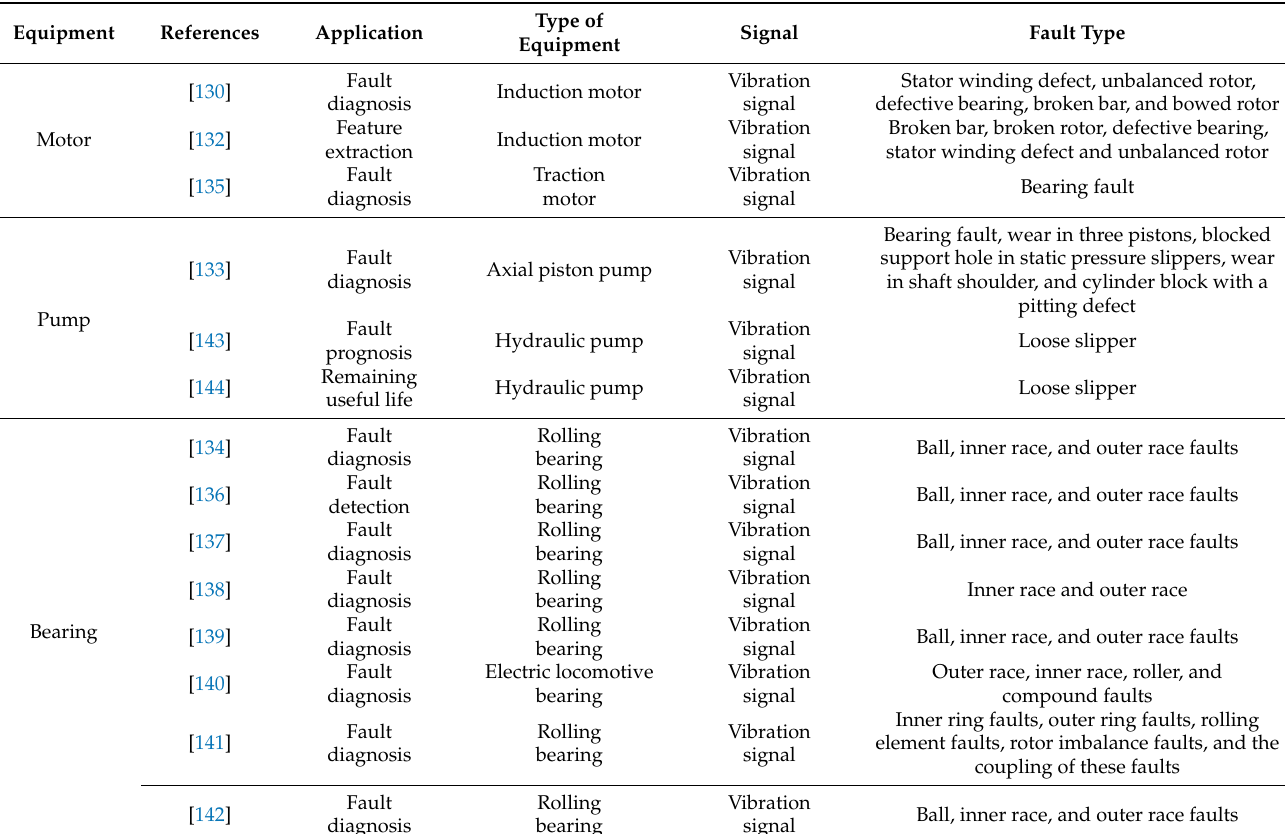
Table 17. Equipment condition monitoring using deep belief